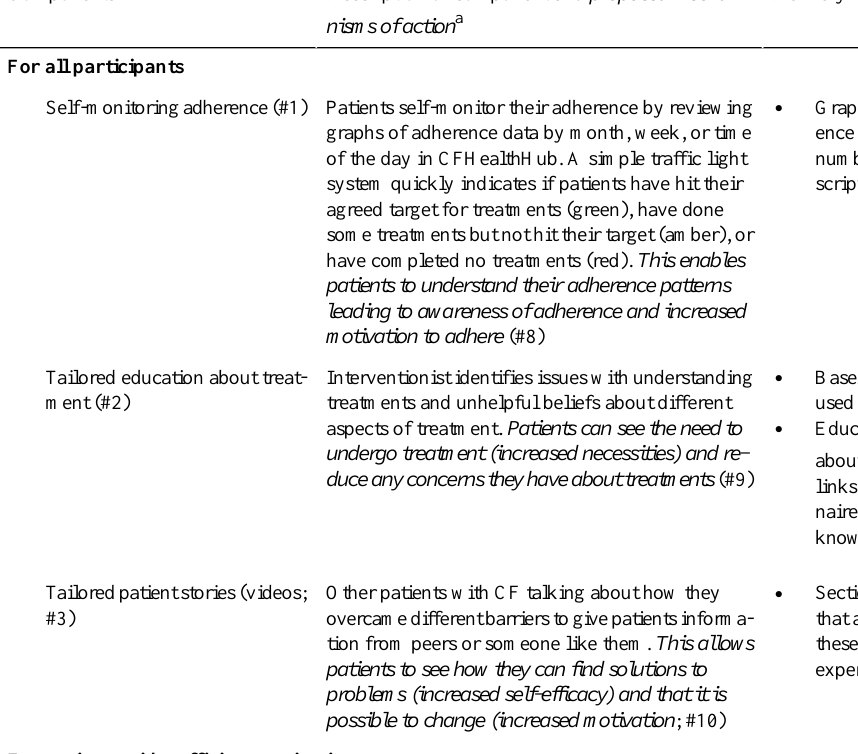
Table 1. Components of the intervention and proposed mechanisms of action. DeliveryDescription of component and proposed